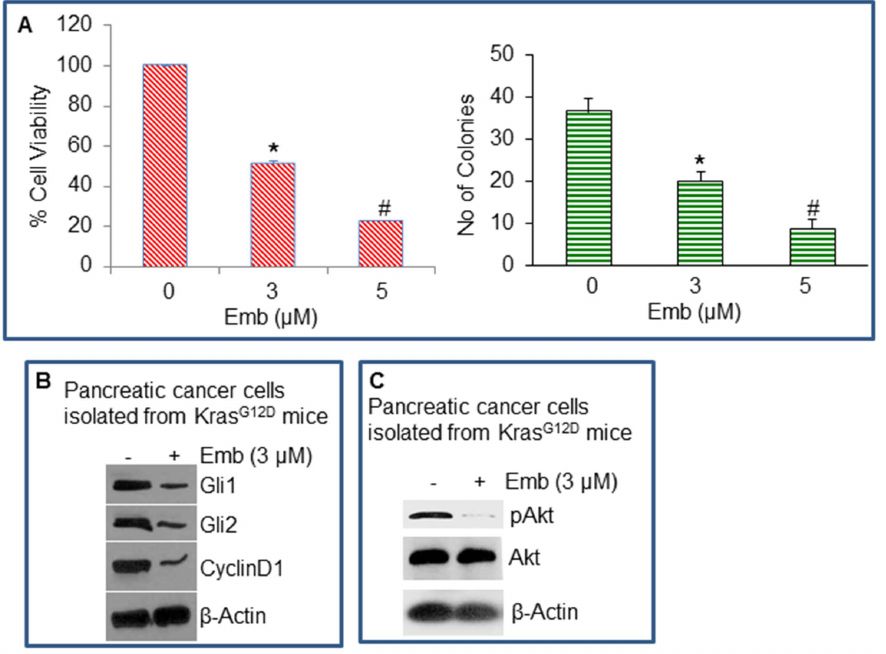
Figure 8. Effects of embelin on cell viability and colony formation, and Shh and Akt pathways in pancreatic cancer cells isolated from Kras G12D mice. (A), Pancreatic cancer cell were isolated from 10-months old Kras G12D mice. Cells were treated with embelin (0–5 m M) to measure cell viability and colony formation at 2 and 21 days, respectively. *=significantly different from control, P , 0.05. (B), Mouse pancreatic cancer cells were isolated from 10 months old Kras G12D mice, and treated with or without embelin (3 m M) for 36 h. At the end of incubation period, crud protein was extracted. Western blot analysis was performed to measure the expression of Gli1 and Gli2. The b -actin was used as a loading control. (C), Mouse pancreatic cancer cells were isolated from 10 months old Kras G12D mice, and treated with or without embelin (3 m M) for 36 h. Western blot analysis was performed to measure the expression of phopho-Akt (pAkt) and Akt. The b -actin was used as a loading control.